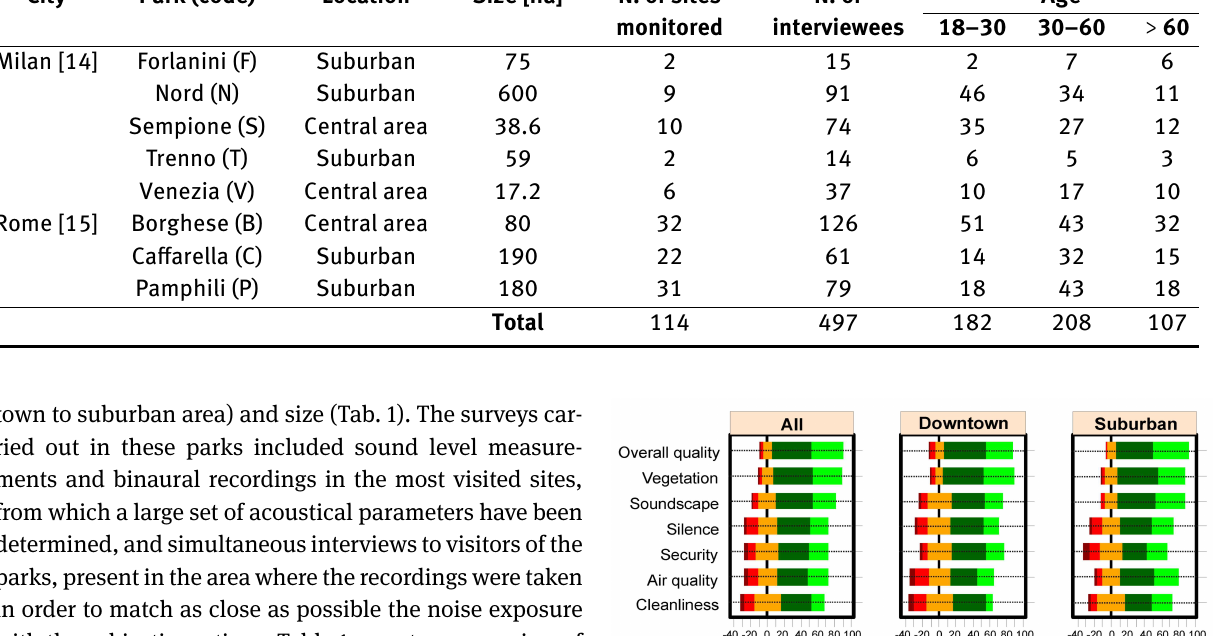
Table 1: Overview of the surveys. City